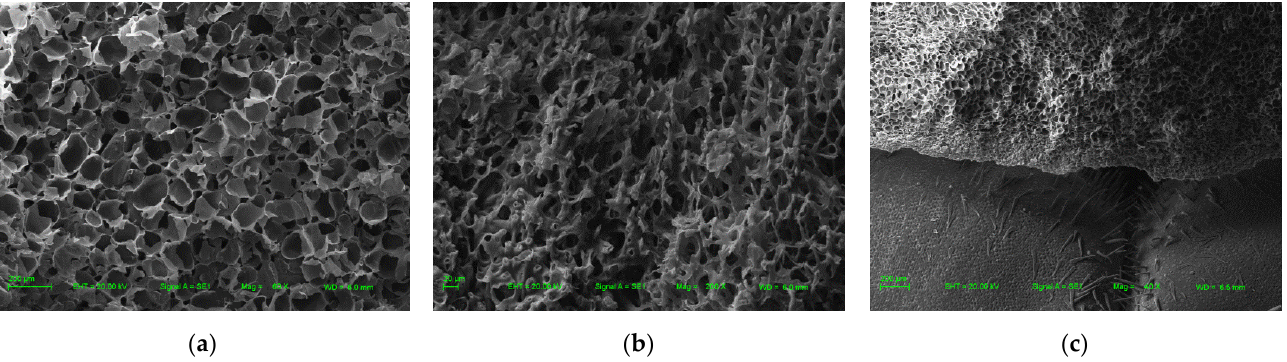
Figure 7. Microstructure of different components of corn cob. ( a ) Microstructure of pith; ( b ) microstructure of woody ring; ( c ) microstructure of glume and its connection to woody ring.